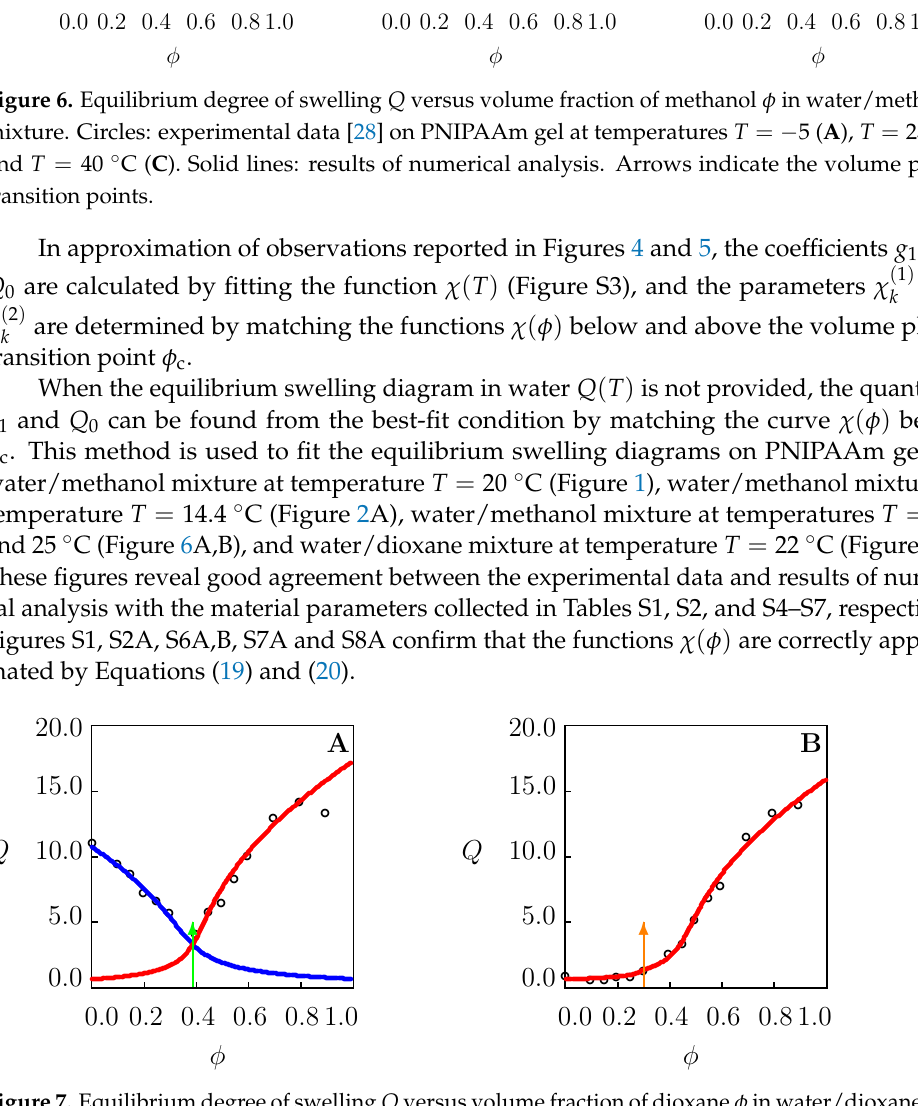
Figure 7. Equilibrium degree of swelling Q versus volume fraction of dioxane φ in water/dioxane mix- ture. Circles: experimental data [37] on PNIPAAm gels at temperatures T = 22 ( A ) and T = 34 ◦ C ( B ). Solid lines: results of numerical analysis. Arrows indicate the volume phase transition